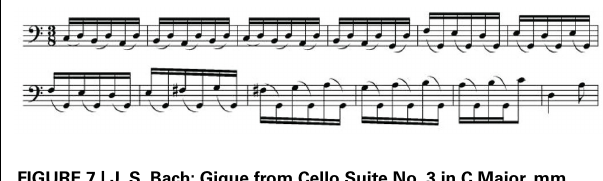
FIGURE 7 | J. S. Bach: Gigue from Cello Suite No. 3 in C Major, mm. 21–32. This part of the Cello suite bears an uncanny resemblance to the stimuli used by neuroscientists to study auditory streaming. In a musical context, the aim seems to create the illusion of polyphony with a largely monodic instrument. Reprinted from Davis (2006).